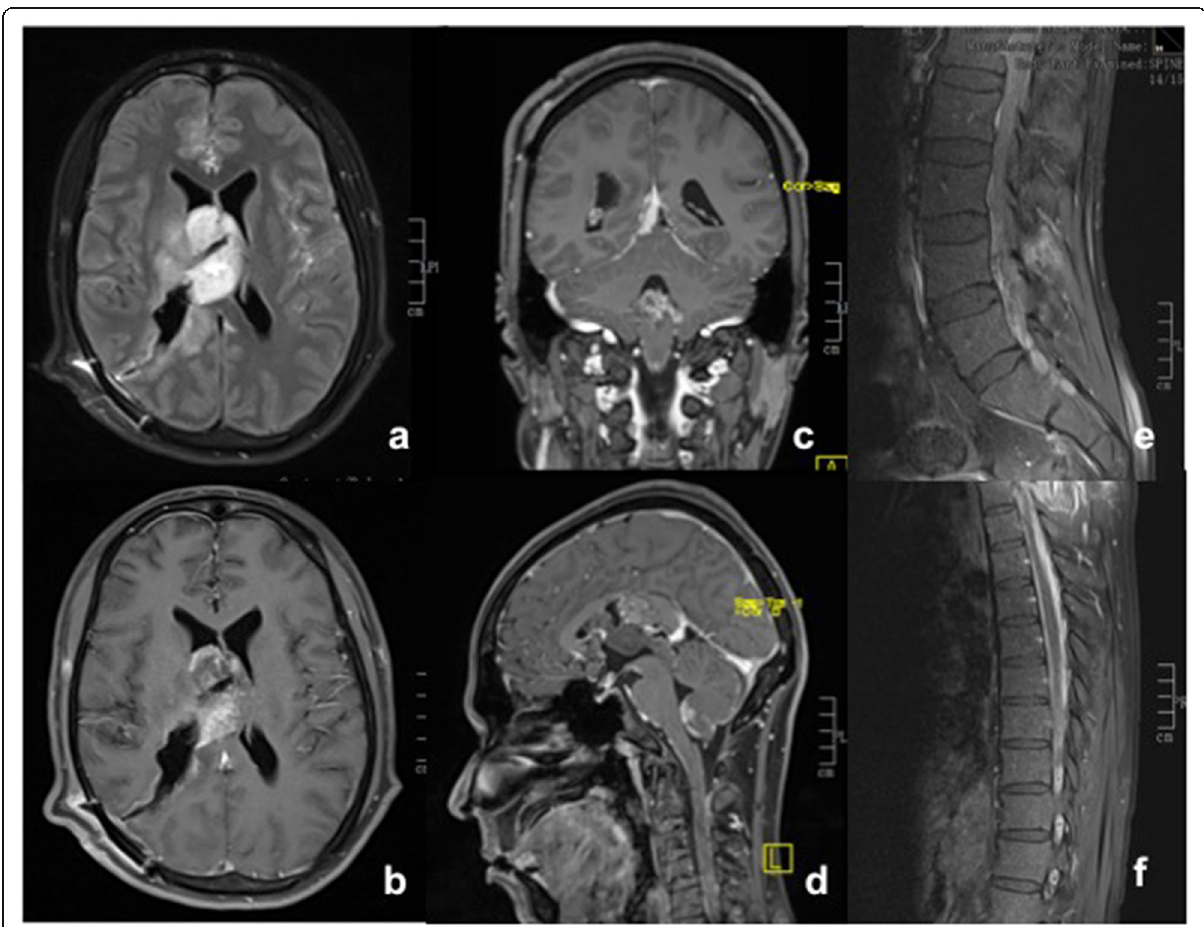
Fig. 3 MRI of brain showed the residual right ventricular tumor mass infiltrating into right thalamus, posterior limb of right internal capsule, and reaching across the midline into the medial part of the left thalamus, causing mass effect over the third ventricle and mild upstream dilatation of the lateral ventricles. Abnormal enhancement was seen along the interpenduncular cistern, prepontine, perimesencephalic basal cistern, Sylvian fissures, cortical sulci, floor of fourth ventricle, and tentorium cerebelli, suggesting leptomeningeal spread. a T2 FLAIR axial section. b – d T1 contrast axial, coronal, and sagittal images. e , f Diffuse leptomeningeal enhancement along pial surface of spinal cord and along the nerve roots of cauda equina without any focal intramedullary